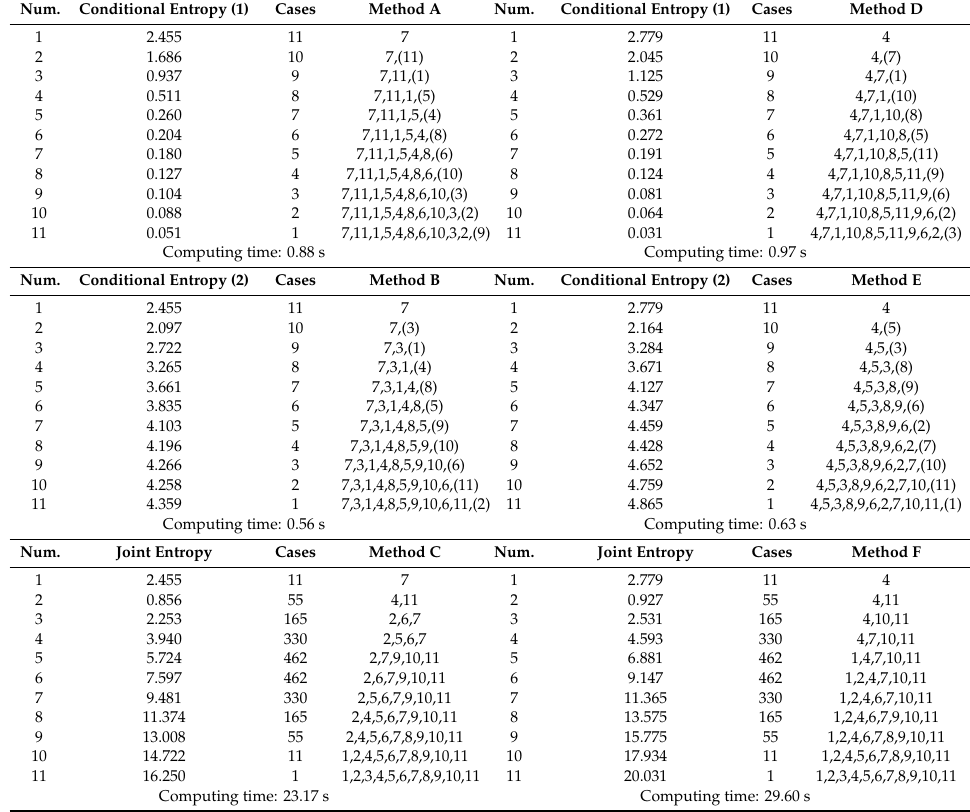
Table A1. Results of a select optimal rain gauge network of methods